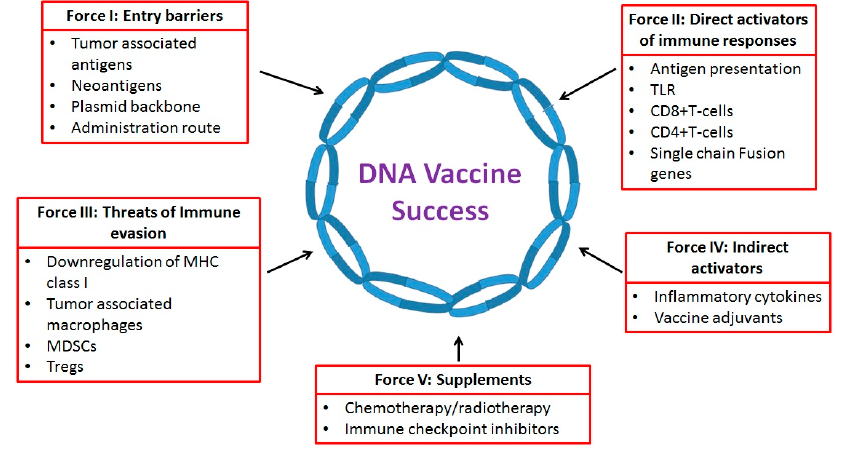
Figure 1. The five forces immune framework affecting DNA vaccine outcomes in cancer therapy. MHC, major histocompatibility complex; TLR, toll-like receptor; MDSCs, myeloid-derived suppressor cells.